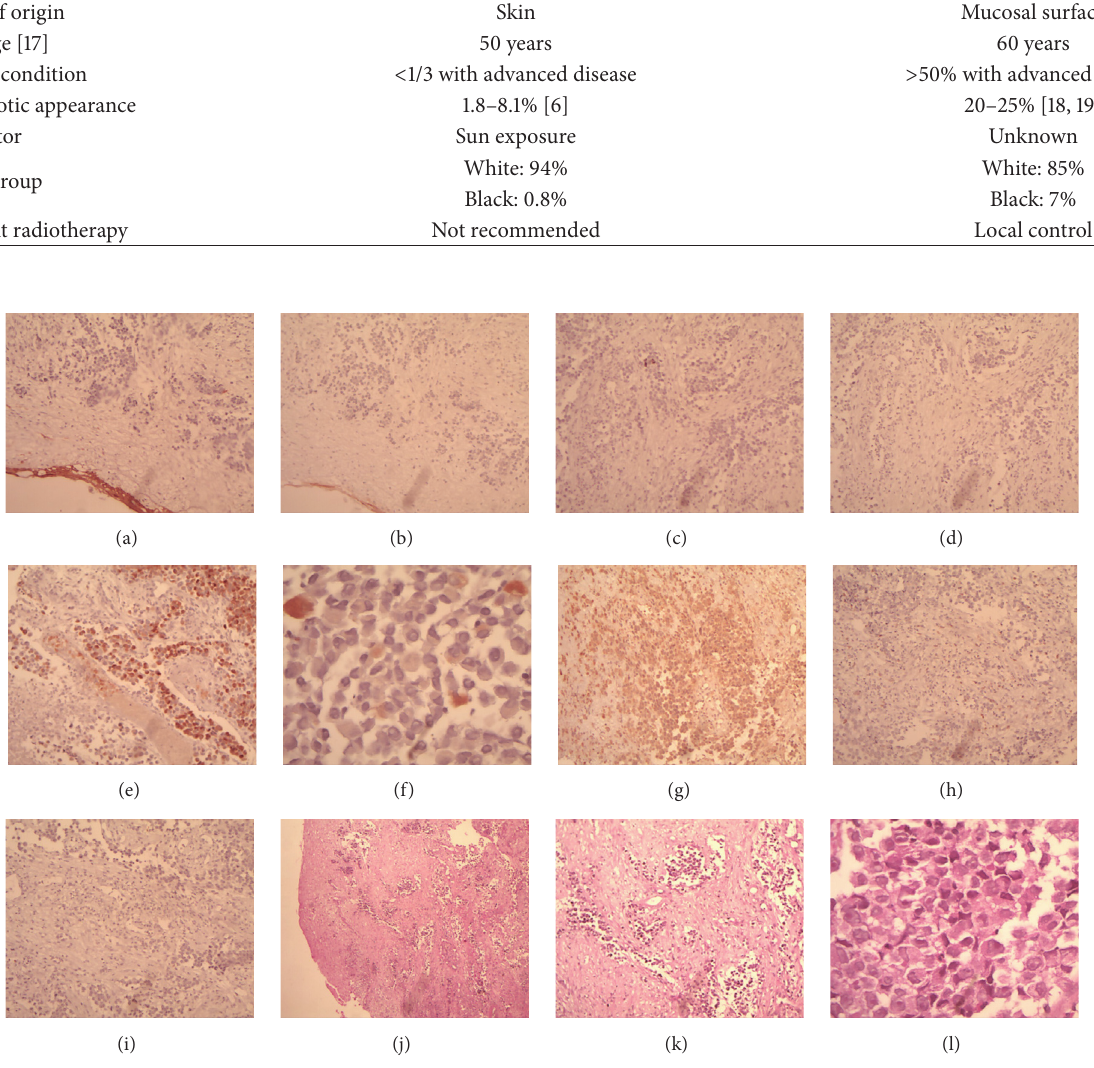
Figure 2: Immunohistochemical profile and histology of the lesion. (a) AE1 + AE3. (b) CD 138. (c) CK 8/18. (d) Desmin. (e) HMB 45. (f) S100 ( × 40)—focal positivity. (g) Vimentin ( × 20)—diffuse. (h) CD3. (i) CD20. (j) HE × 10. (k) HE × 20. (l) HE × 40. Pleomorphic, polyhedral giant cells with large hyperchromatic nucleoli with a diffuse